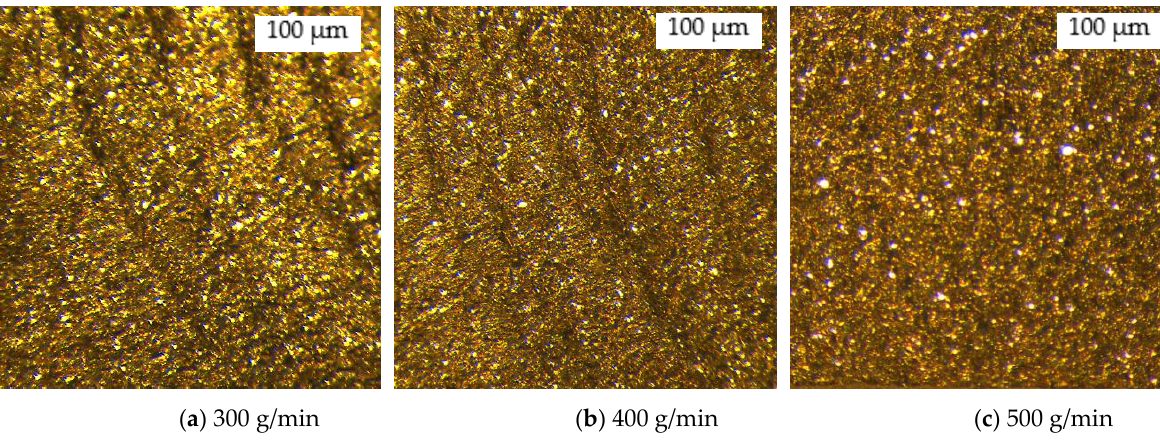
Figure 10. Topography of AISI 304L cut surface with 4 mm thickness using varied Abrasive mass flow rate.